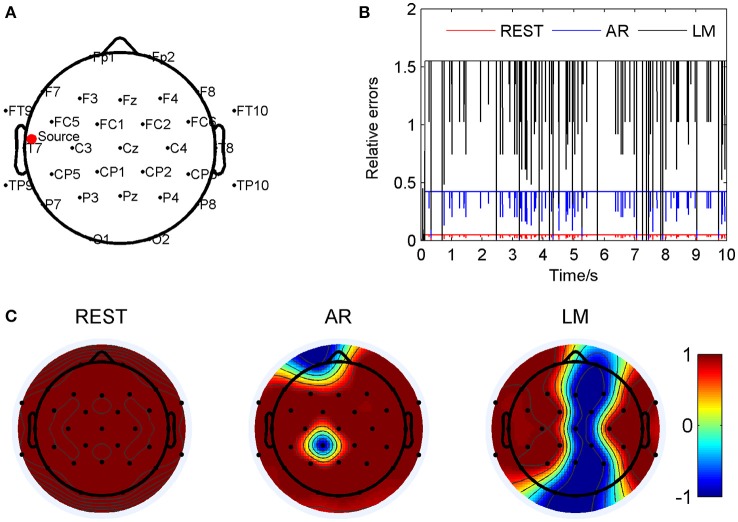
Comparison of the three reference electrode methods for the one source of BWV772 shown in Figure 1A. (A) The location of the source is (−0.65674, −0.06352, 0.56552). The red dot indicates the projected position of the source on the scalp surface. (B) Relative errors of the music signals with three references compared to the standard signals. (C) Correlation coefficients of three references with the standard signals.